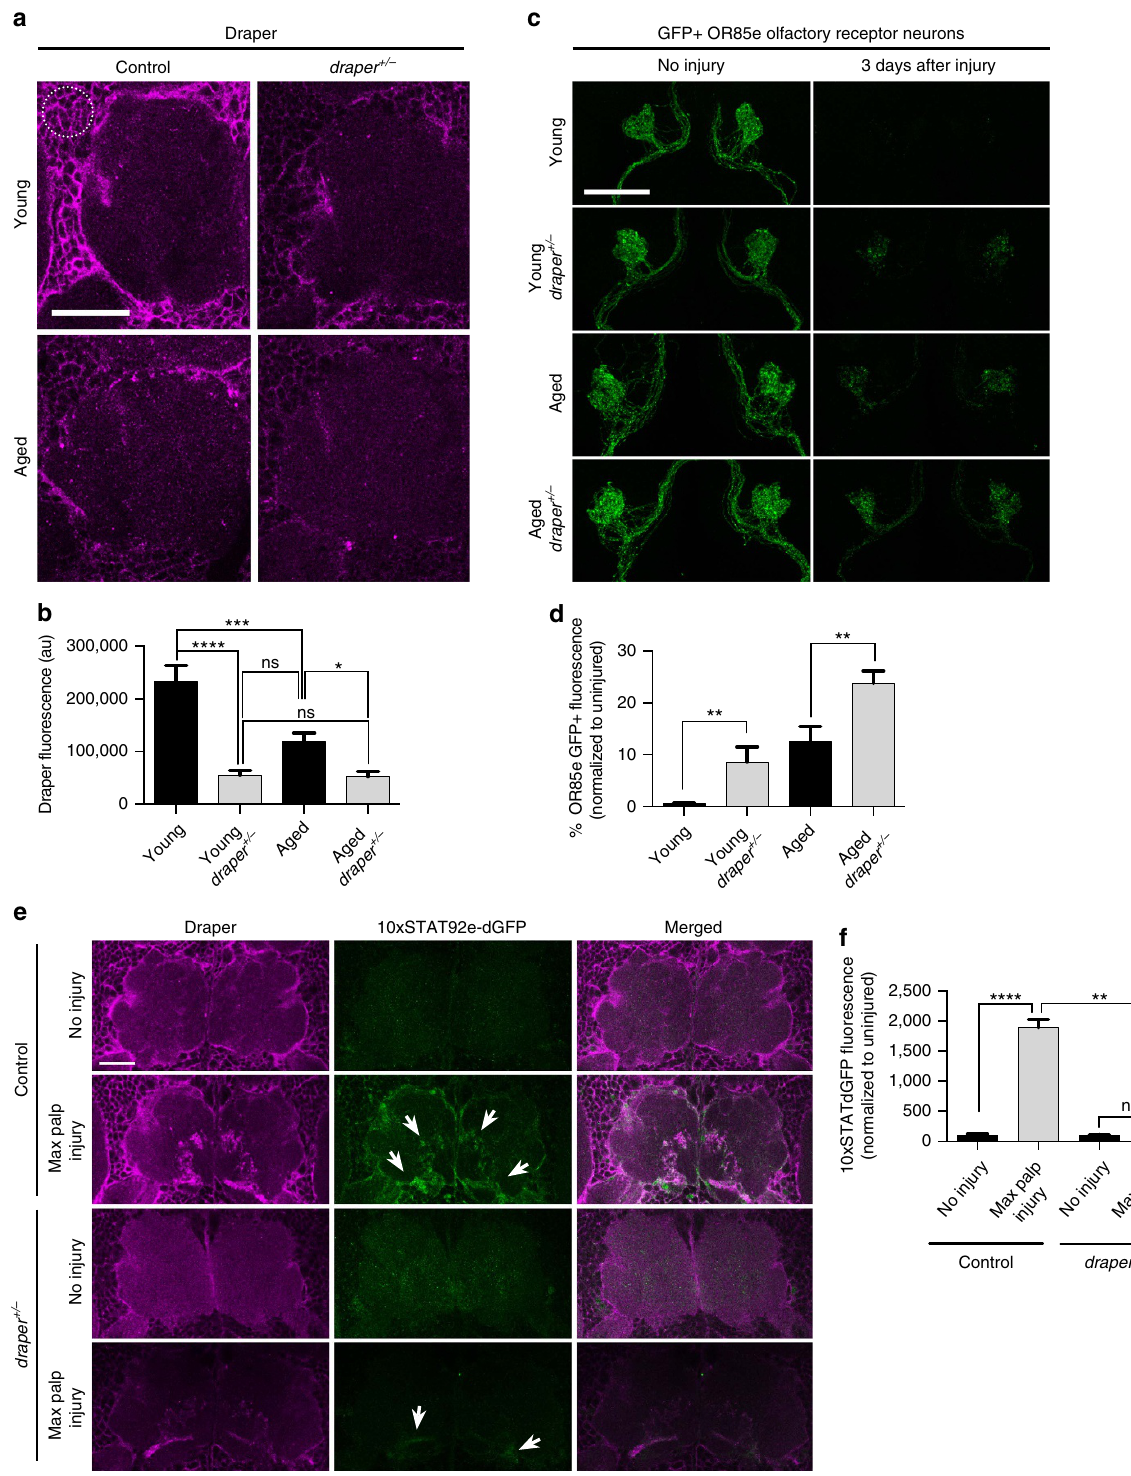
Figure 3 | Glial responses to degenerating axons are attenuated in draper heterozygotes. ( a ) Representative single confocal slices of Draper immunostained brains: young ( OR85e-mCD8::GFP ), young draper þ / (cid:2) ( OR85e-mCD8::GFP; draper D 5 / þ ), aged ( OR85e-mCD8::GFP ), aged draper þ / (cid:2) ( OR85e-mCD8::GFP; draper D 5 / þ ). White dotted outline indicates region of interest (ROI) used for quantification of basal Draper in b . ( b ) Quantification of cortical Draper immunostainings shown in a ; mean ± s.e.m. plotted; NS, not significant, * P o 0.05, *** P o 0.001 and **** P o 0.0001, one-way analysis of variance (ANOVA) with Sidak post hoc test; N Z 16. ( c ) Representative confocal projections of GFP-labelled OR85e axons. ( d ) Quantification of axon clearance in c ; mean ± s.e.m. plotted; ** P o 0.01; unpaired t test; N Z 14. ( e ) Single confocal images of antennal lobe regions showing STAT92E-dependent activation of dGFP (green) and Draper (magenta) in Control ( 10xSTAT92E-dGFP/ þ ) and draper þ / (cid:2) ( 10xSTAT92E-dGFP/ þ ; draper D 5 / þ ) animals. Arrows show expected upregulated of 10xSTAT92E- dGFP reporter activity after injury. ( f ) Quantification of dGFP on maxillary glomeruli shown in e ; mean ± s.e.m. plotted; NS, not significant, ** P o 0.01 and **** P o 0.0001, one-way ANOVA with Sidak post-hoc test; N Z 18. Scale bars, 30 m